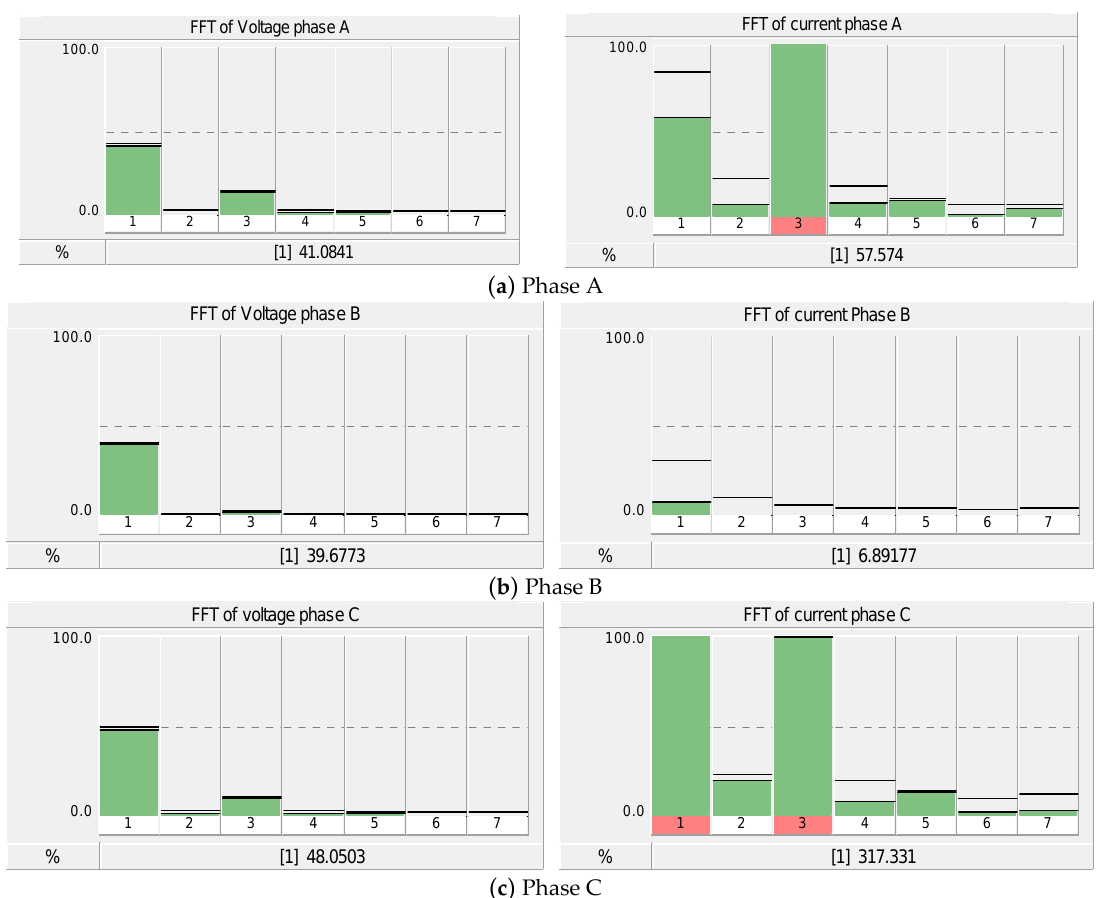
Figure 18. The frequency spectrums of the phase voltage and current at the LV side (0.4 kV) transformer 500 kVA when the BRKB open circuit is at 0.3 s.